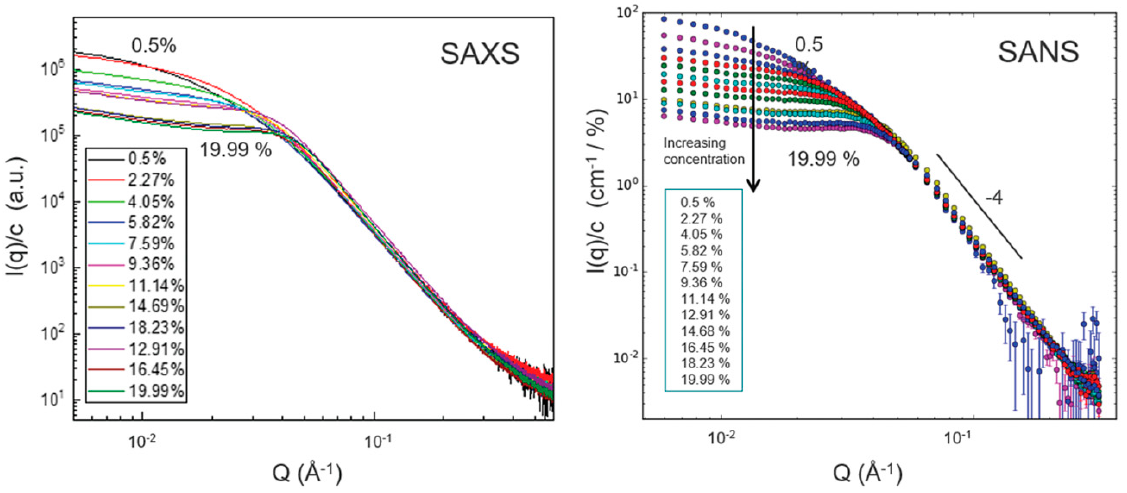
SAXS and SANS scattering patterns for citric acid-stabilized Fe 3 O 4 particles at varying concentrations, normalized to the particle concentration. The SANS data have been background-subtracted for the H 2 O contribution. (Reproduced from [233] with permission from The Royal Society of Chemistry).